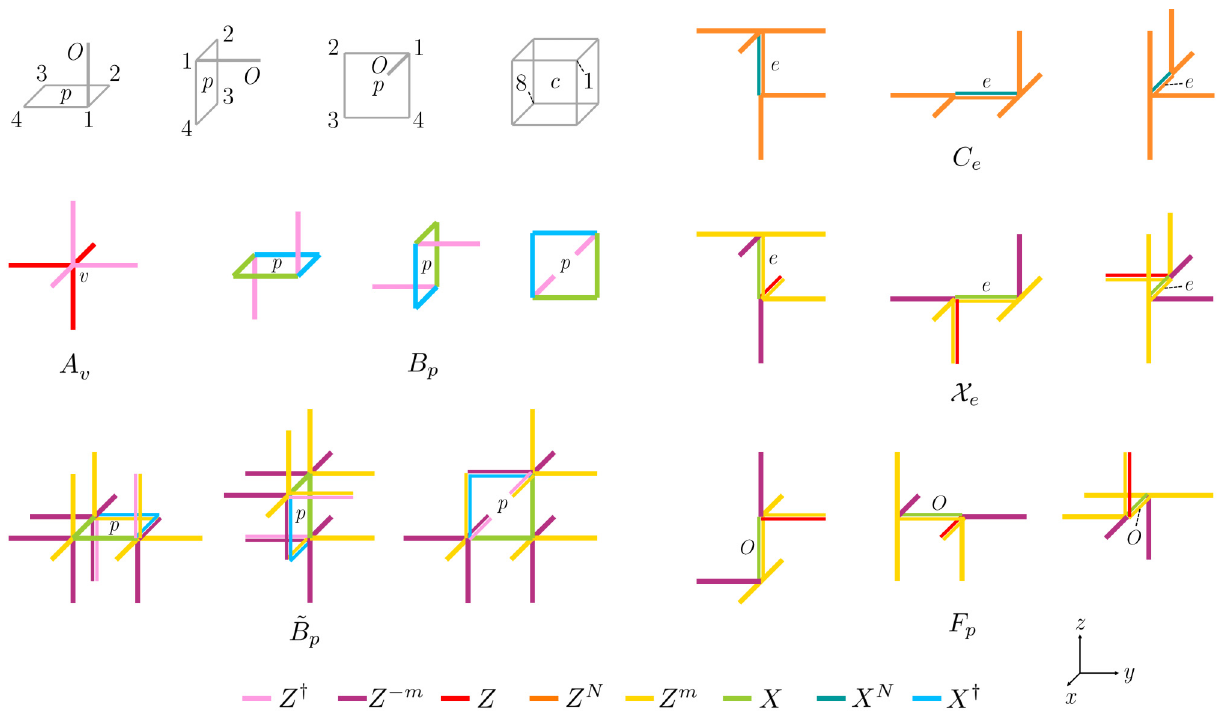
FIG. 5. Vertex term A v , plaquette terms B p , modified plaquette terms ˜ B p , boson hopping operators C e , anyon hopping operators X e , and flippers F p defined with respect to the O edge of p , in the general N = 2 n case. Each operator is a tensor product of Z 2 N Pauli operators over the indicated qudits, with a legend shown at the bottom. Edges with two colors represent a product of the two operators, with Z -type operators preceding X type. All operators have an overall phase of + 1 except the X e operators that have an overall phase of e − i π m ( N − 1 )/ 2 N . A polynomial representation of these operators is given in Appendix